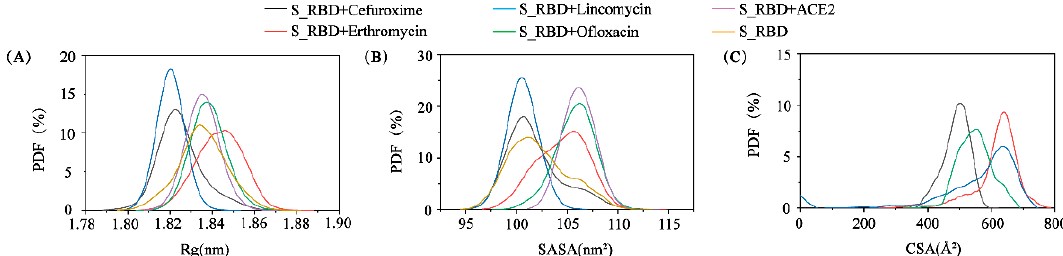
Figure 4. The physical and conformational properties of the six systems. The probability distribution function (PDF) of ( A ) the radius of gyration (Rg), ( B ) the solvent accessible surface area (SASA) and ( C ) the contact surface area (CSA) in each MD system. The S_RBD with Cefuroxime system (black), S_RBD with Erythromycin system (red), S_RBD with Lincomycin system (blue), S_RBD with Ofloxacin system (green), S_RBD with ACE2 system (purple) and S_RBD system (orange).